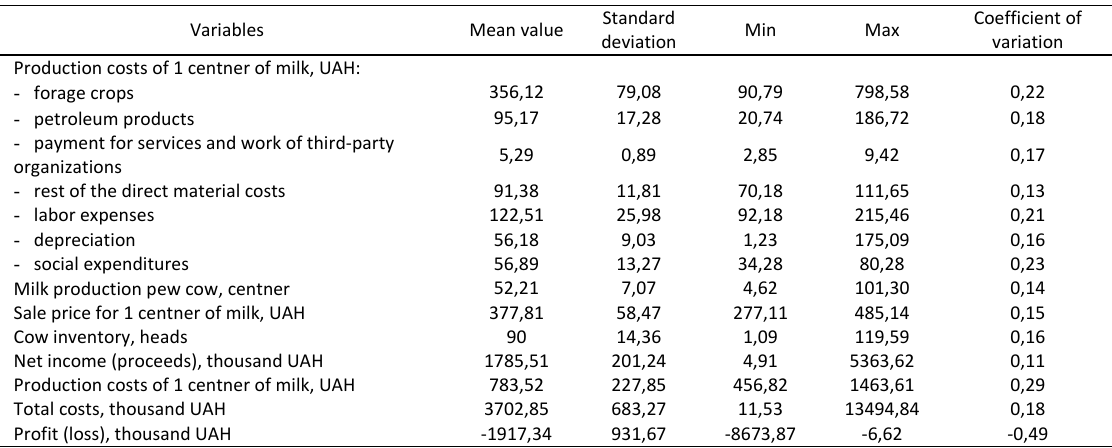
Table 2: Statistical characteristic of the simulation modeling variables of milk production in the researched agricultural enterprise by the Monte Carlo method Variables